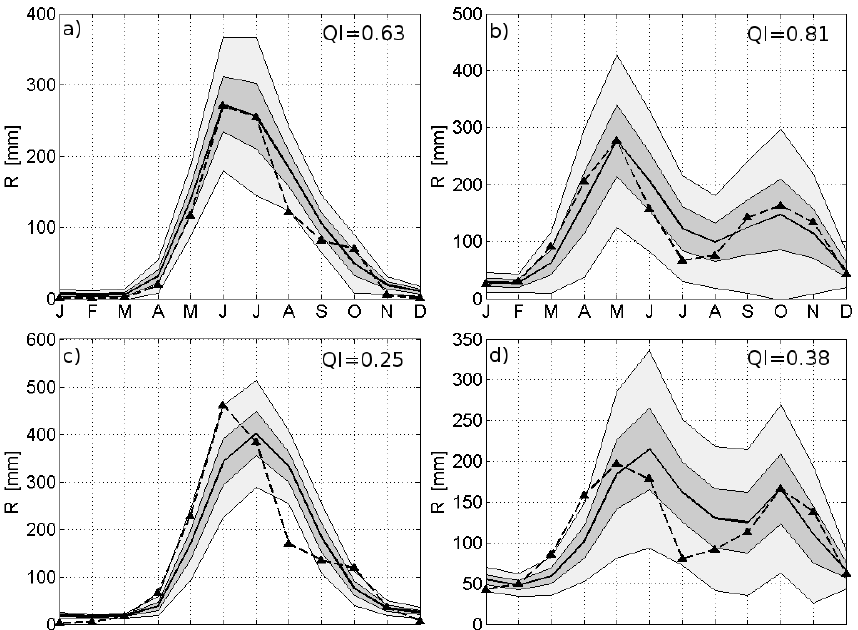
Fig. 5. Application at the local scale. Observed (solid line) and simulated (dashed line) runoff regimes. Dark (light) grey area represents the confidence bands of the observed runoff at 40% (80%). (a) Savara at Eau Rousse; (b) Sesia at Ponte Aranco; (c) Rutor at Promise; (d) Toce at Candoglia. In the upper left corner of each panel a measure for the model performances, the Quality Index QI, is reported.